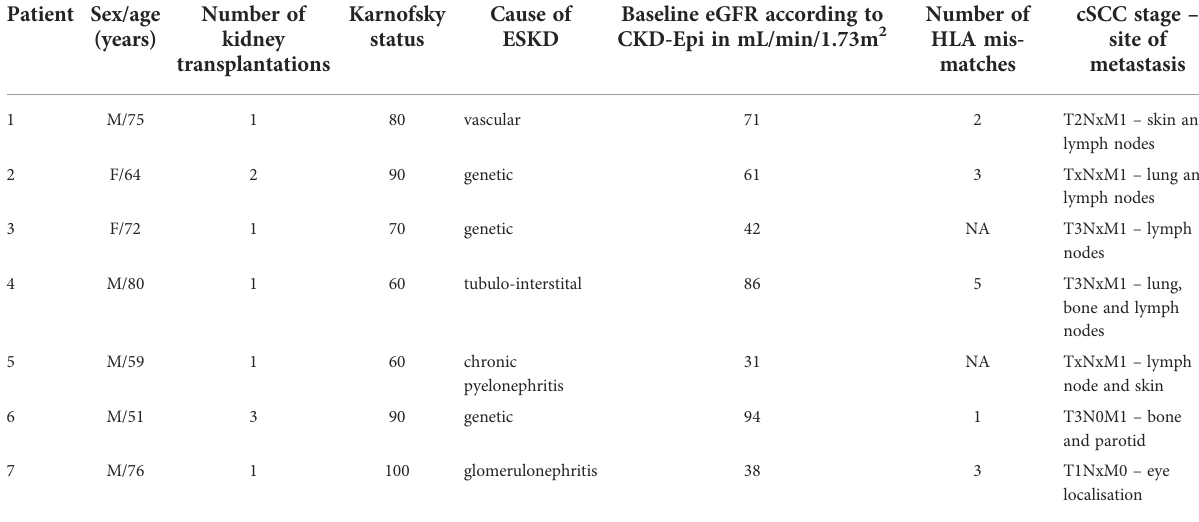
TABLE 2A Details of the characteristics and outcomes of the patients included in the study.